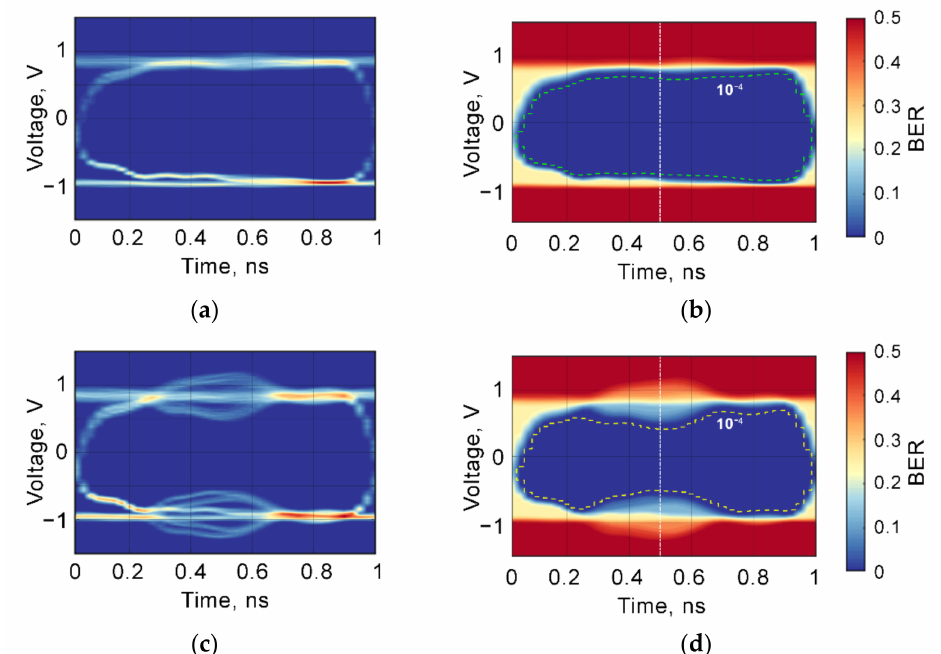
Figure 1. ( a ) Eye diagram of the victim signal without crosstalk; ( b ) BER diagram of the victim signal without crosstalk; ( c ) eye diagram of the victim signal with crosstalk; ( d ) BER diagram of the victim signal with crosstalk. Bit rate is 1